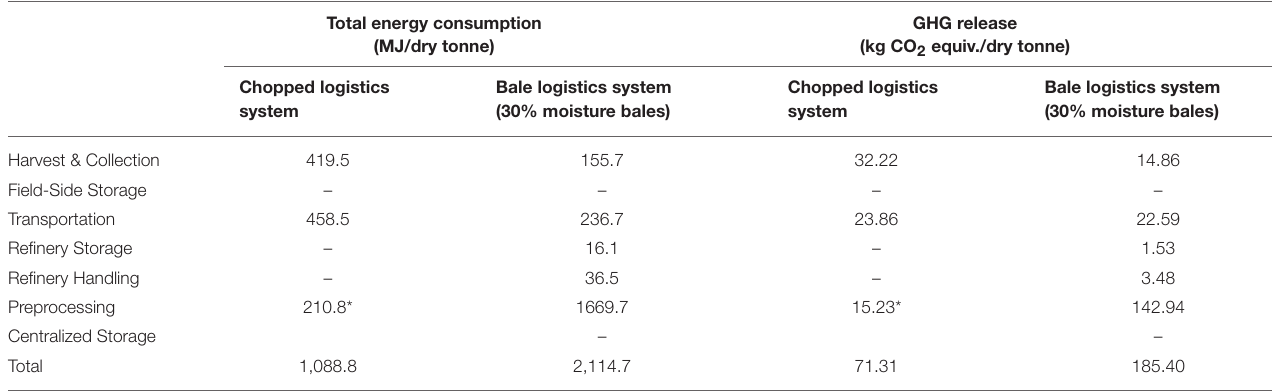
TABLE 8 | Estimated energy consumption and GHG release for corn stover in the chopped and baled logistics systems.